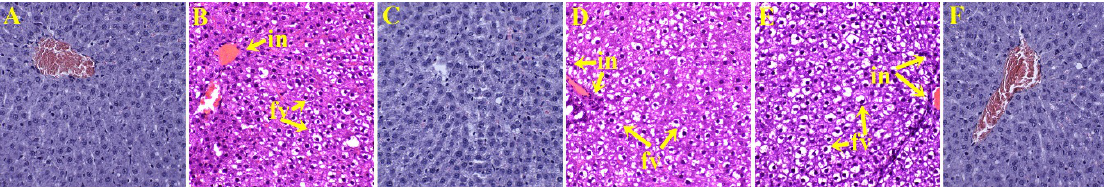
Figure 3. Haematoxylin and eosin staining of hepatocytes (original magnification ×20) showing inflammatory cells (marked as “in”) and hepatocytes with fat vacuoles (marked as “fv”) in rats fed the C ( A ); CG ( B ); CB ( C ); H ( D ); HG ( E ) and HB ( F ) diet.